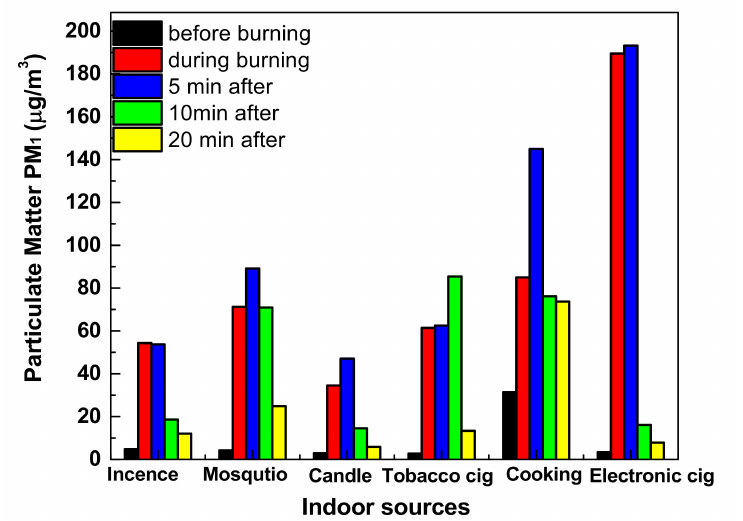
Figure 4. Particulate matter mass concentration (PM 1 ) for six indoor aerosol sources (incense, mosquito coils, candles, tobacco cigarettes, cooking and electronic cigarettes) at different times (before being turned on, during operation and after being